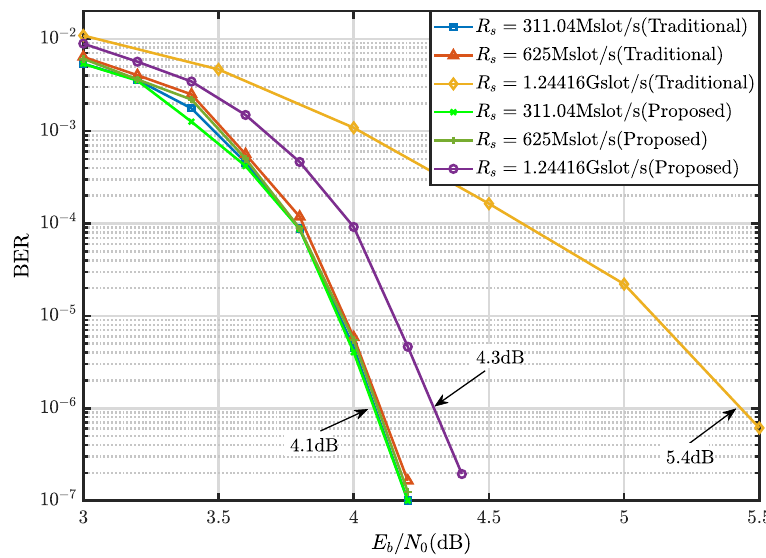
Figure 7. BER simulation results ( F s = 2.5